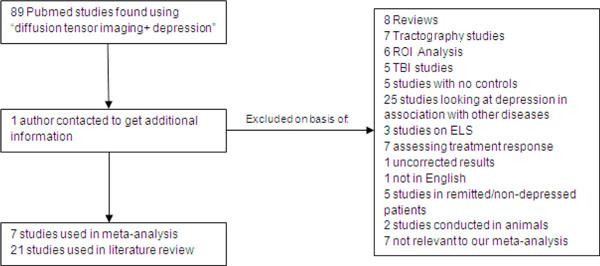
Summary of exclusion criteria used in finding suitable studies to be included in our meta-analysis. Seven studies were selected to be included in the meta-analysis based on extensive exclusion criteria as outlined in Methods.